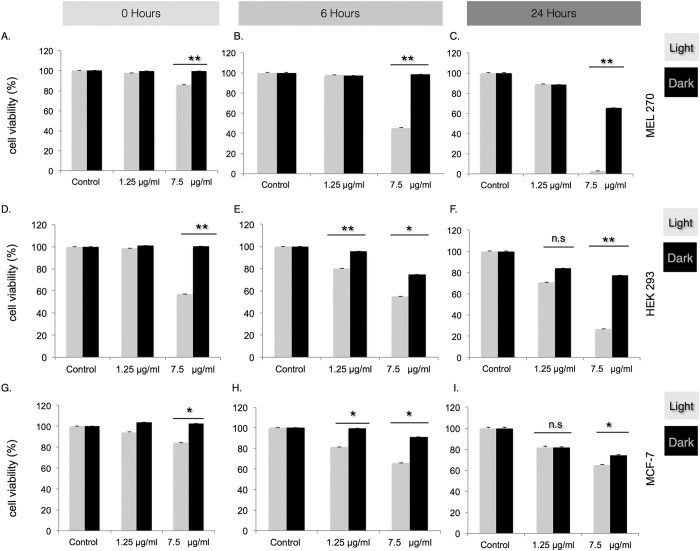
Effects of VP on cell growth (MEL 270, MCF-7, and HEK293) when shielded or not shielded form ambient light exposure.MTT assay was performed on MEL 270 (6A, 6B, 6C), HEK293 (6D, 6E, 6F) and MCF-7(6 G, 6 H, 6I) after treatment with vehicle (control), low dose (LD, 1.25 μg/ml) or high dose (HD, 7.5 μg/ml) of Verteporfin (VP) for 0, 6 and 24 hours. Cell viability was significantly decreased in cells not shielded from ambient light, whereas toxicity was minimal in 0 h and 6 h in darkness and increased at 24 hours.